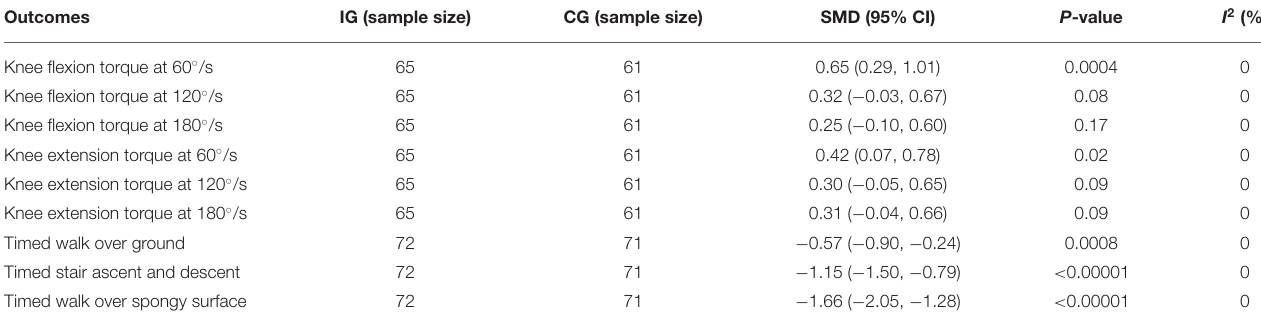
TABLE 3 | Meta-analysis results of muscle strength and mobility when proprioceptive training compared to no intervention.